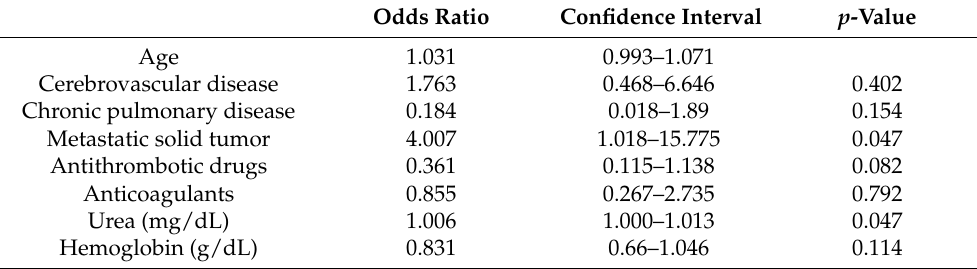
Table 4. Multivariate analysis of parameters associated with need for hemostatic intervention. Odds Ratio Confidence Interval p -Value Age 1.031